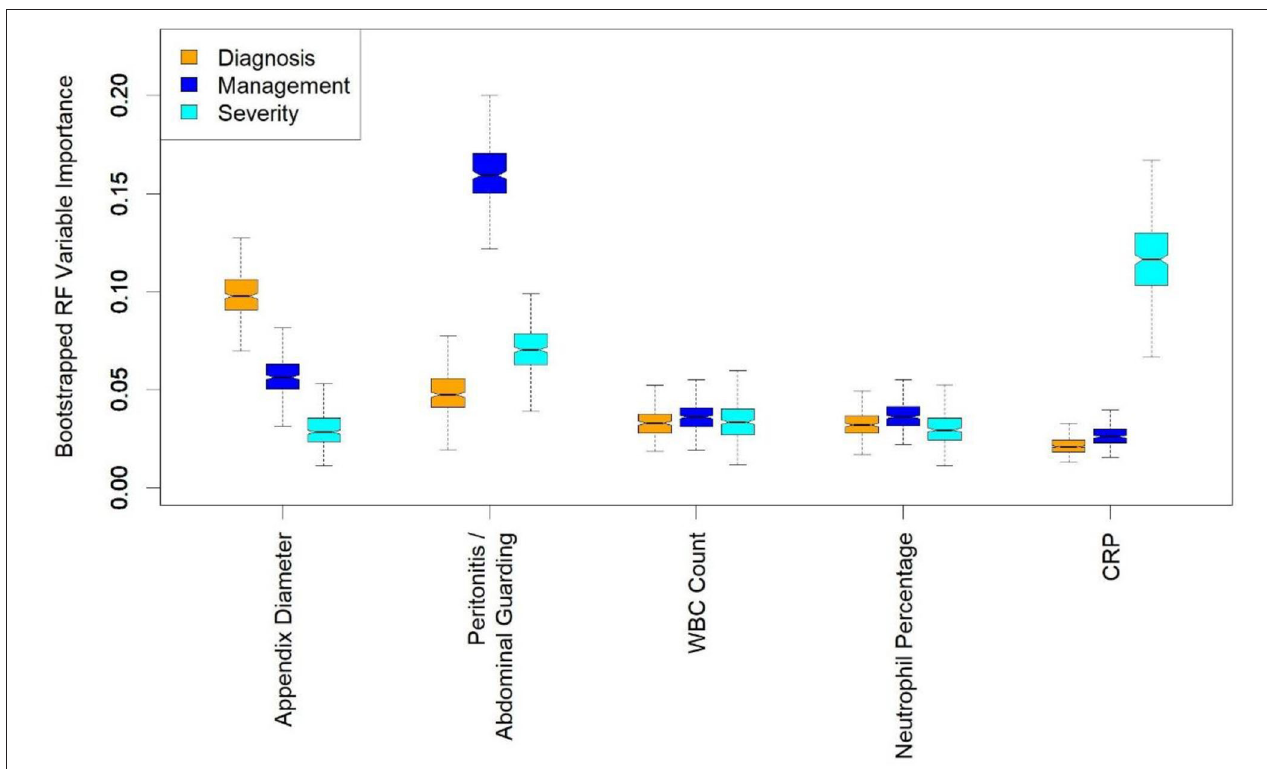
FIGURE 2 | Boxplots of random forest (RF) importance values for a few most important predictors. RF variable importance quantifies how important each variable is for predicting the considered outcome. Appendix diameter, peritonitis/abdominal guarding, white blood cell (WBC) count, neutrophil percentage, and C-reactive protein (CRP) are among 10 most important variables for predicting diagnosis, management and severity. Distributions were obtained by training random forest classifiers on 300 bootstrap resamples of the dataset. The bootstrapping was performed to provide uncertainty about variable importance values, rather than mere point